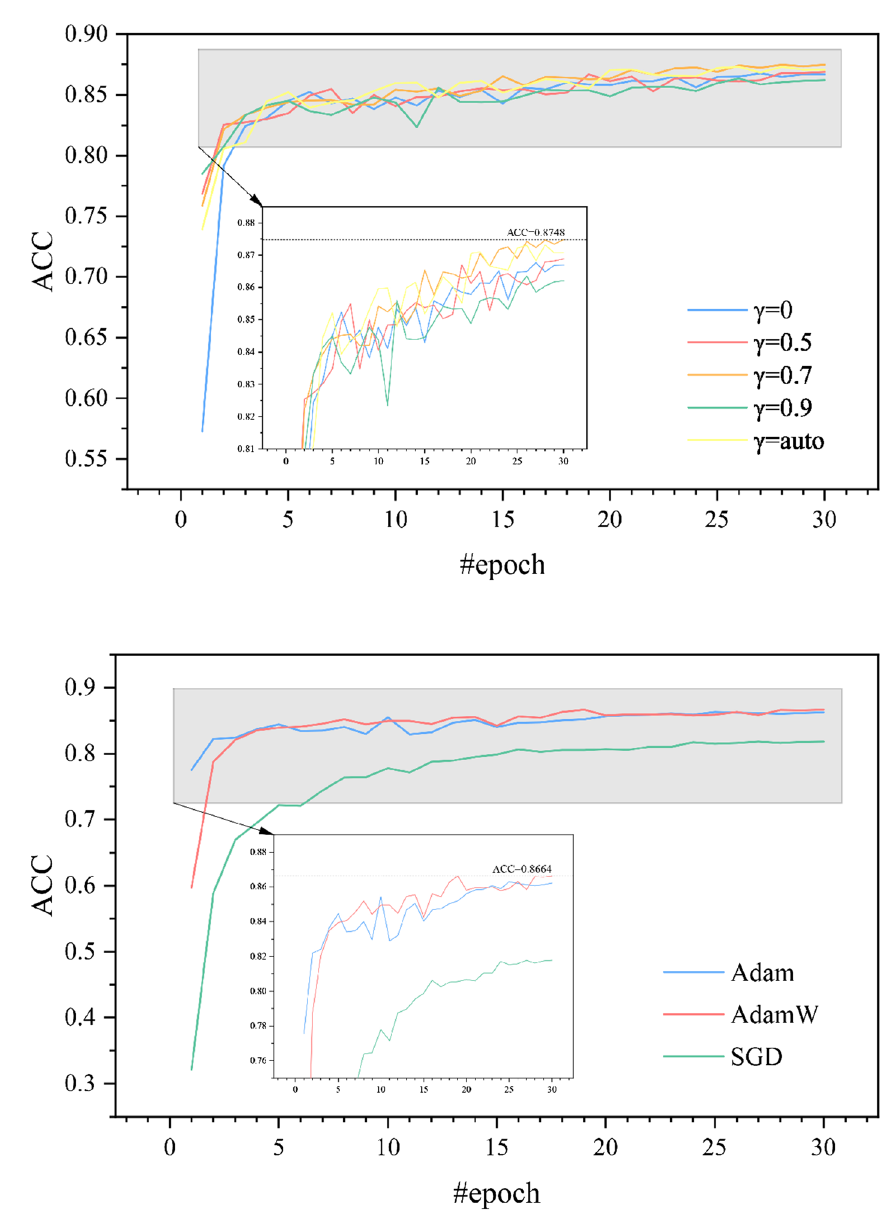
Fig. 7 SLDC hyperparameter analysis